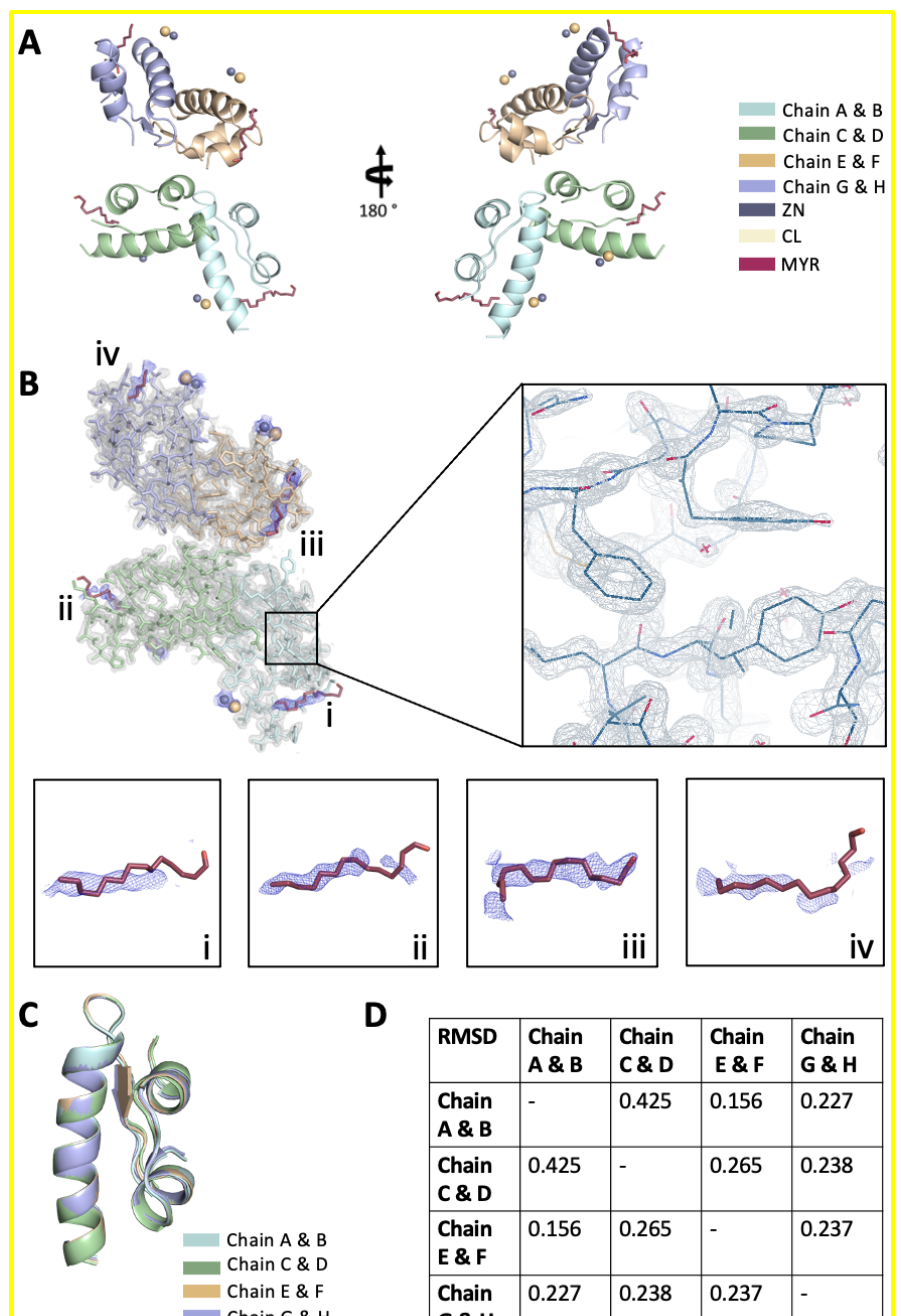
Figure 1. The 8HGZ structure at cryogenic temperature. ( A ) Detemir structure is represented in cartoon view. Myristic acid (MYR), zinc (ZN), chloride (CL), and phenol (IPH) are shown in stick representation. ( B ) The refined 2Fo-Fc electron density map, covering the detemir, is shown in gray, the weaker electron density for MYR is colored in blue, ZN and CL are colored in dark salmon, and IPH is colored in smudge. (i–iv) Close-up representation of weak electron density of MYRs from monomer i to monomer iv of 8HGZ are shown as panels. ( C ) Each monomer of detemir is superposed in PyMOL, and ( D ) RMSD values in Å are indicated in the